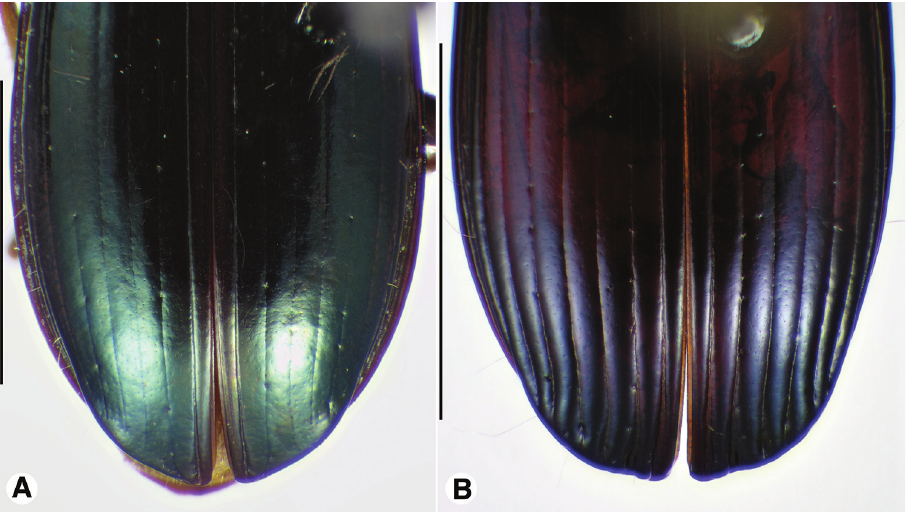
Figure 10. Digital images of elytra excluding base of Neodiachipteryx species, dorsal aspect. A N. cariniger (Putzeys) B N. davidsoni sp. n.. Scale bars 3